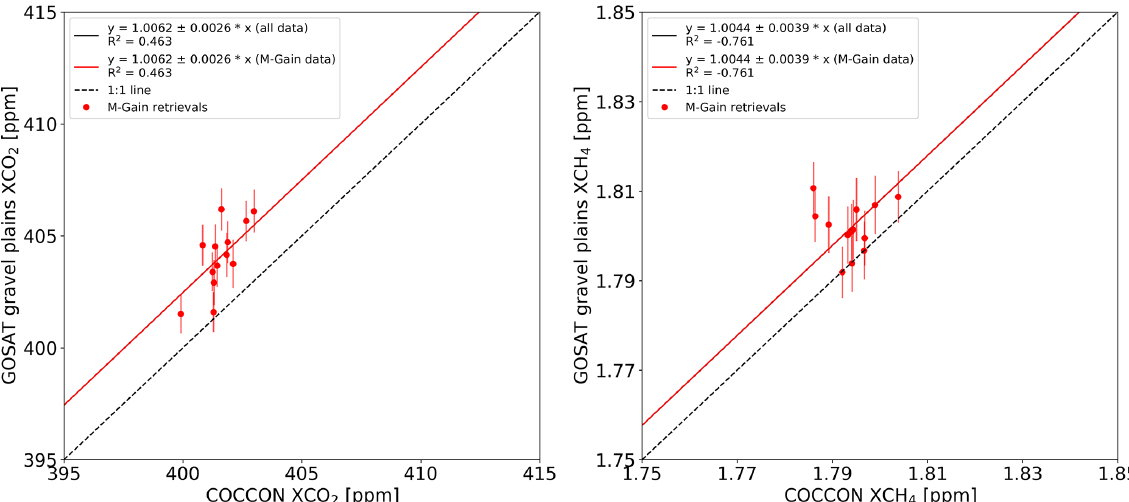
Figure 11. Correlation plots between coincident COCCON Gobabeb observations and GOSAT measurements over the gravel plains between 2016 and 2019. For this area, GOSAT only performed M-gain soundings (red dots). The solid red line is the best-fit line through all M-gain data points. The dotted black line is the 1:1 line. Error bars denote the 1 σ standard deviation of the hourly mean values for COCCON measurements and the measurement error for the GOSAT